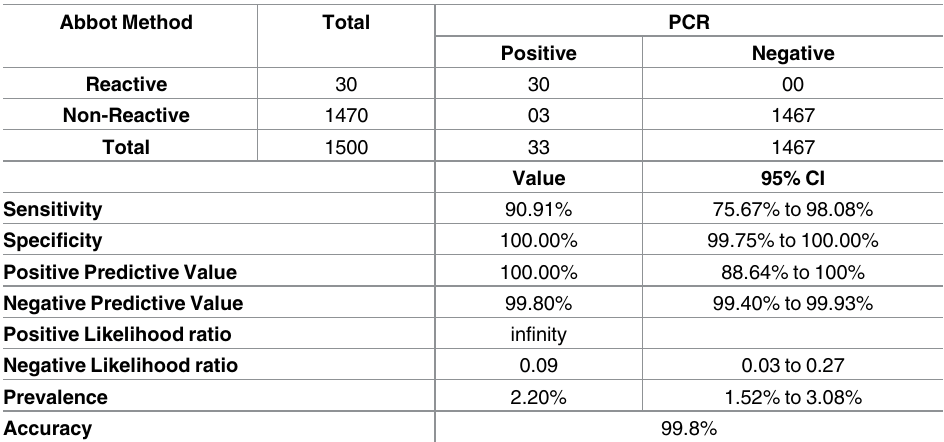
Table 3. Overall results of Abbott Architect ® (n = 1500).